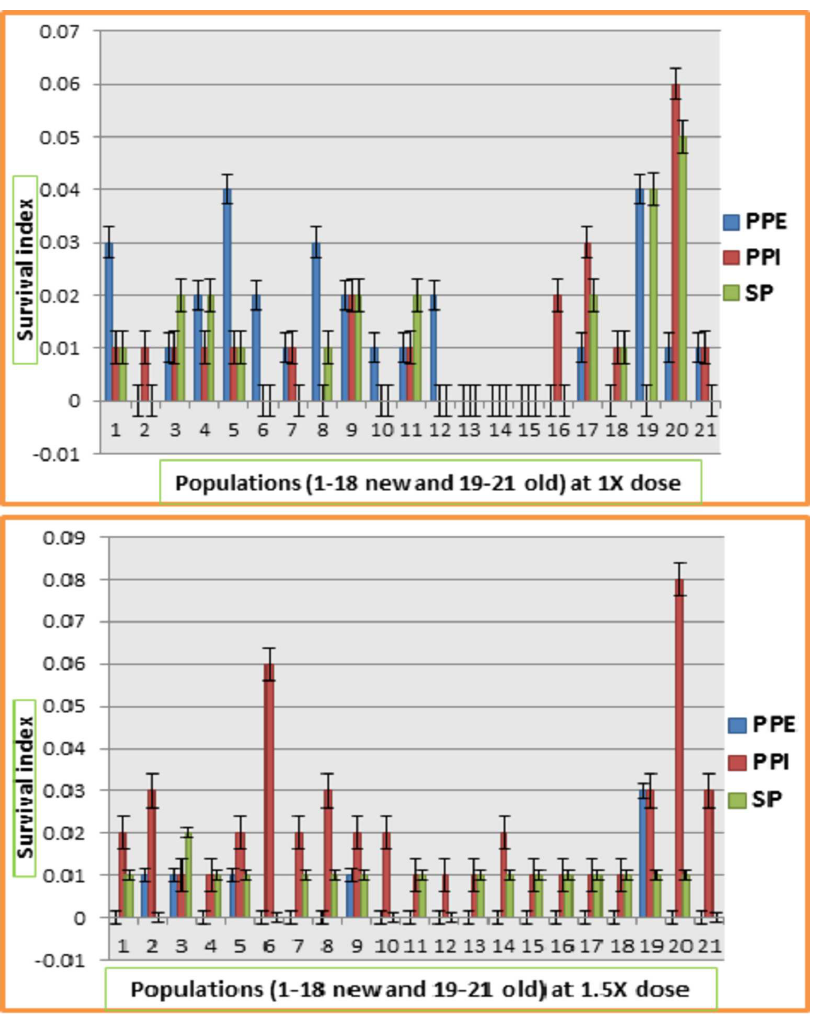
Fig 2. Response of 21 populations of lentil for survival index at different doses of Ally max at three different screening